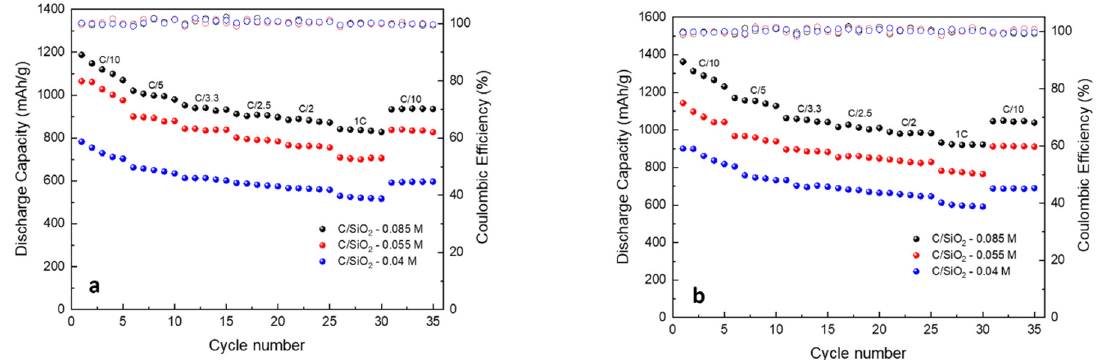
Figure 11. Rate capability of ( a ) C/SiO 2 -0.04 M, C/SiO 2 -0.055 M, and C/SiO 2 -0.085 M uncalendered electrodes and ( b ) C/SiO 2 -0.04 M, C/SiO 2 -0.055 M, and C/SiO 2 -0.085 M calendered electrodes, five cycles at C/10, C/5, C/3.3, C/2.5, C/2, 1C, and C/10.